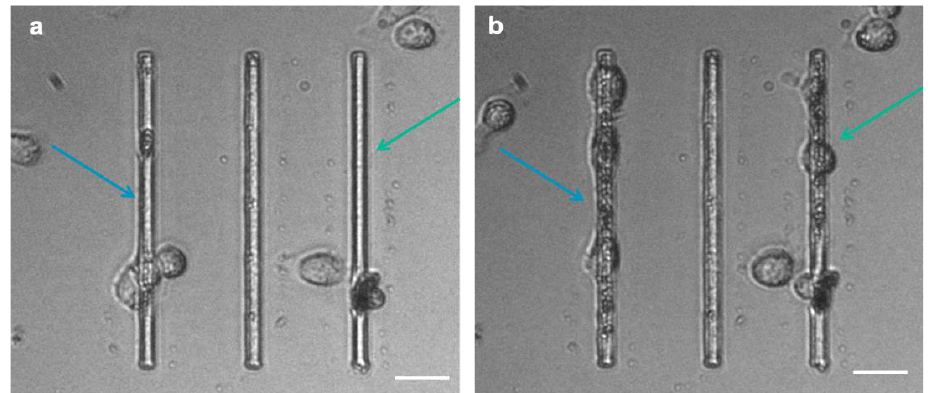
Figure 9. Cell-tracking frames (extracted from the SM1 videos) show MDA cancer cells grown on the micro-gaps (4 µm wide): the arrows indicate the zones where cells have produced ECM at the beginning ( a ) and 10 h after migration analysis ( b ). (Scale bar: 25 µm).